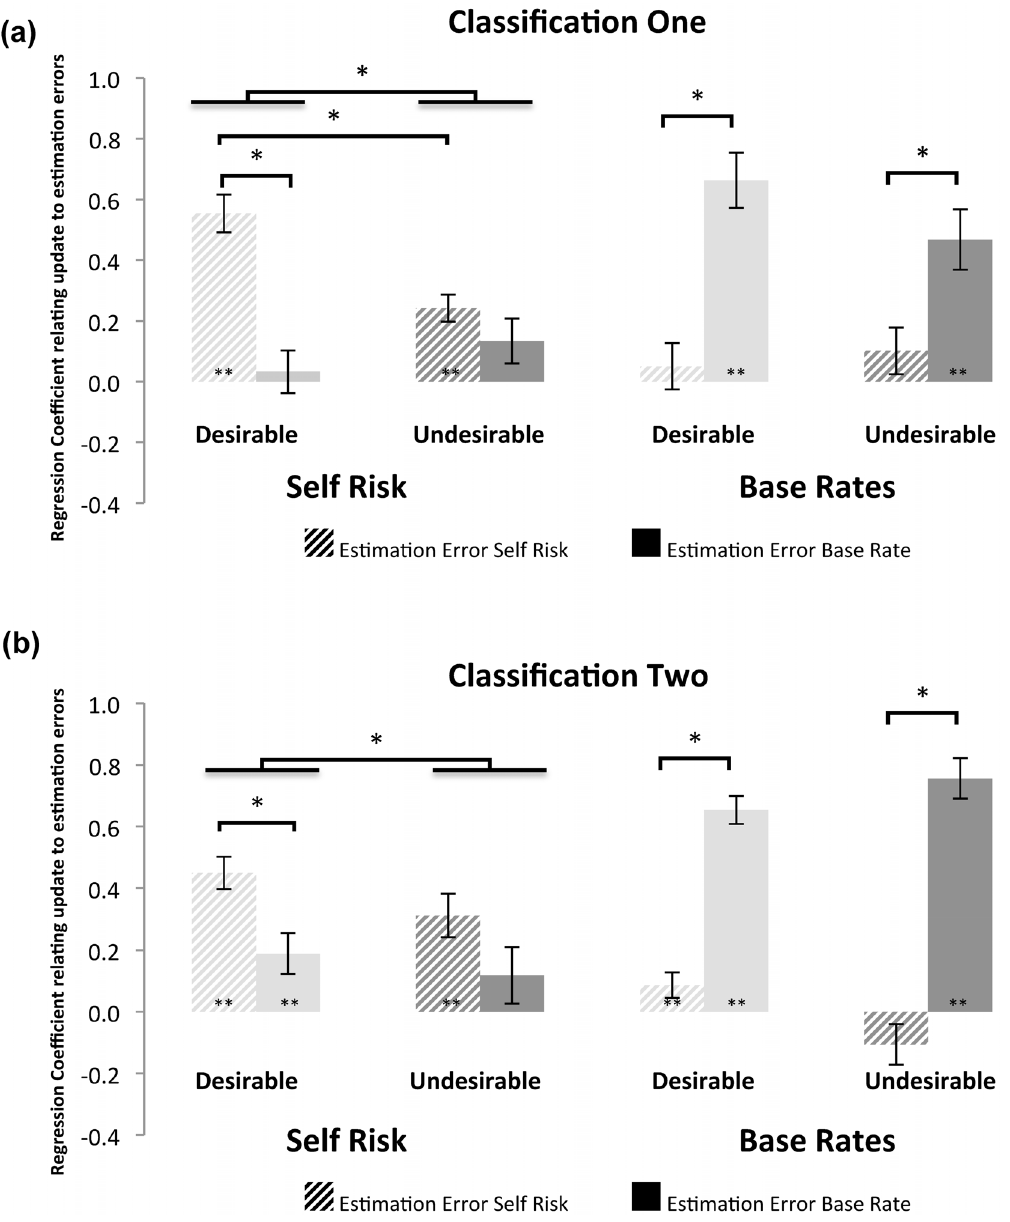
Figure 3. Regression coefficients predicting update from estimation errors. Estimation Error of self risk (i.e. the difference between a participants’ estimate of self risk and provided base rate) significantly predicted update of self risk both for trials in which subjects received desirable and undesirable information, and under both classifications. Estimation Error of base rate (i.e. the difference between a participants’ estimate of base rate and provided base rate) significantly predicted update of base rate both for trials in which participants received desirable and undesirable information, and under both classifications. Error bars are SEM; * indicates statistical significance at a threshold of P , 0.05, two tailed paired sample t- test after controlling for relevant factors; ** indicates significantly different to a mean of 0, one sample t-test (P , 0.05).